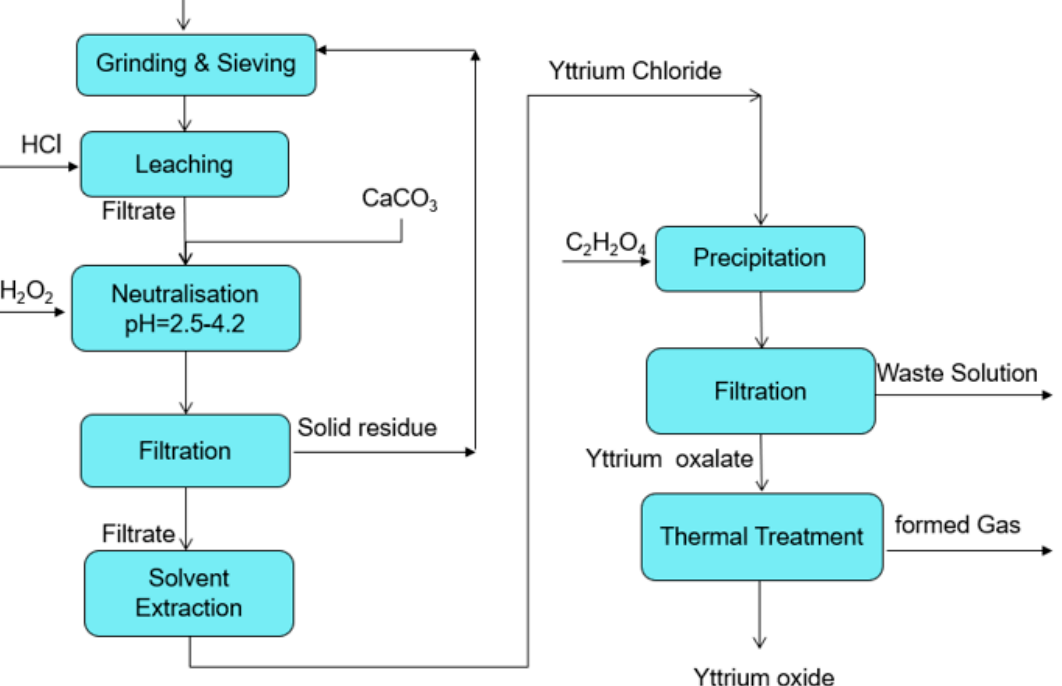
Figure 11. Combined hydrometallurgical and pyrometallurgical method for production of yttrium